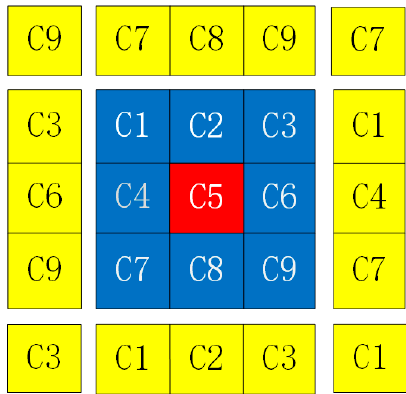
Figure 6. The Moore neighborhood and symmetric boundary condition.